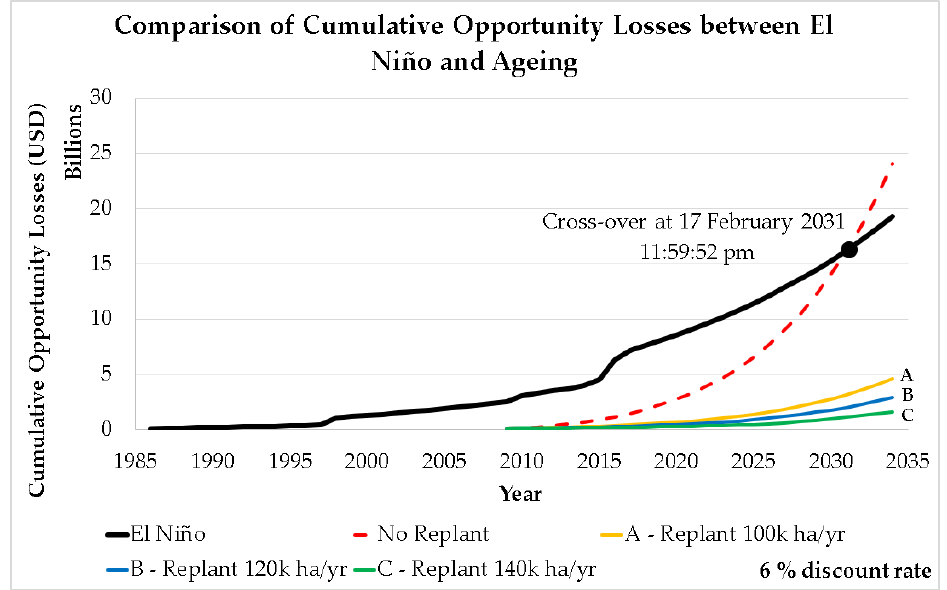
Figure 9. Comparison of cumulative opportunity losses between impact of El Niño and ageing with multiple replanting scenarios [26].